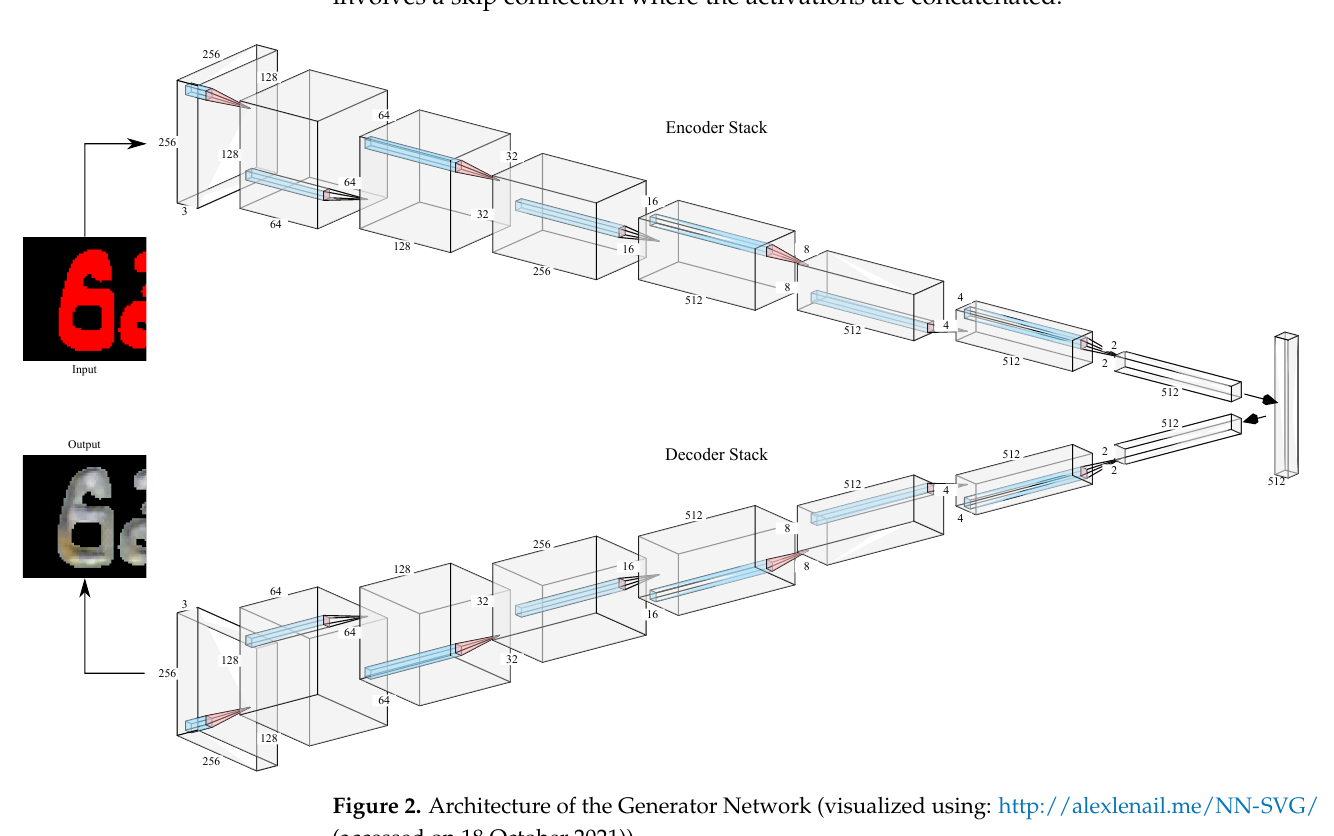
Figure 2. Architecture of the Generator Network (visualized using: http://alexlenail.me/NN-SVG/ (accessed on 18 October 2021)).